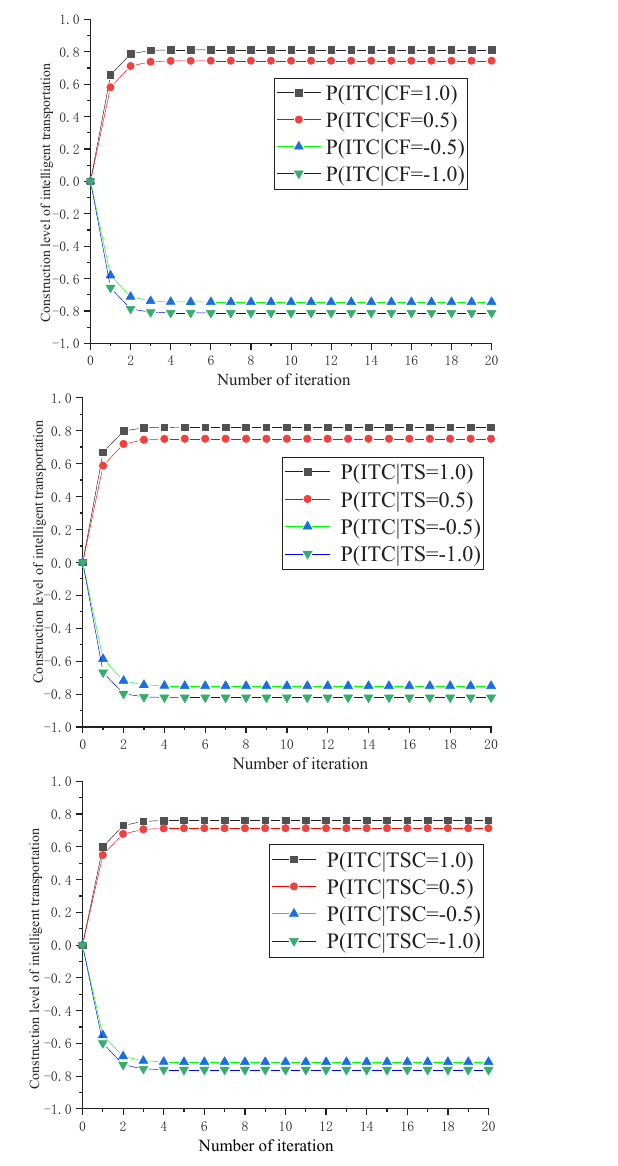
Table 3 . Cronbach’s α coefficient ranging from 0.904 to